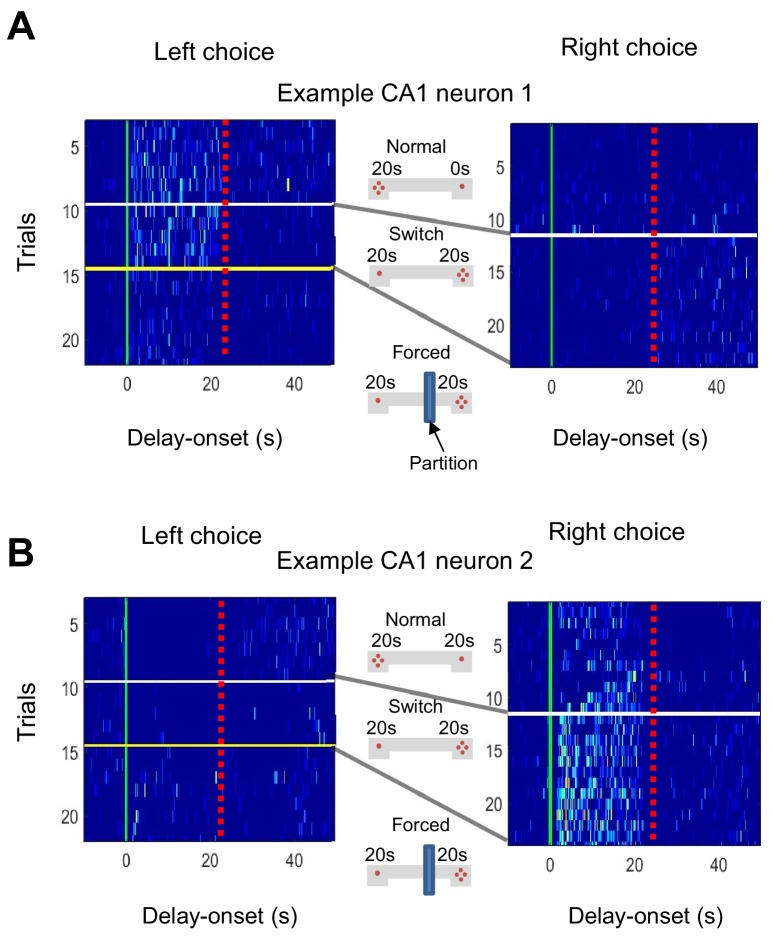
Firing in CA1 delay-active cells depended on animal preference.Forced conditions in which the animals were forced to choose one side by a partition (here, left side). The yellow line indicates the trial converted to forced conditions. (A) The firing in the left side disappeared when the preference to the left side was extinguished. (B) Simultaneously, other neurons showed increased firing when the preference recovered to the other side (here, the right side).